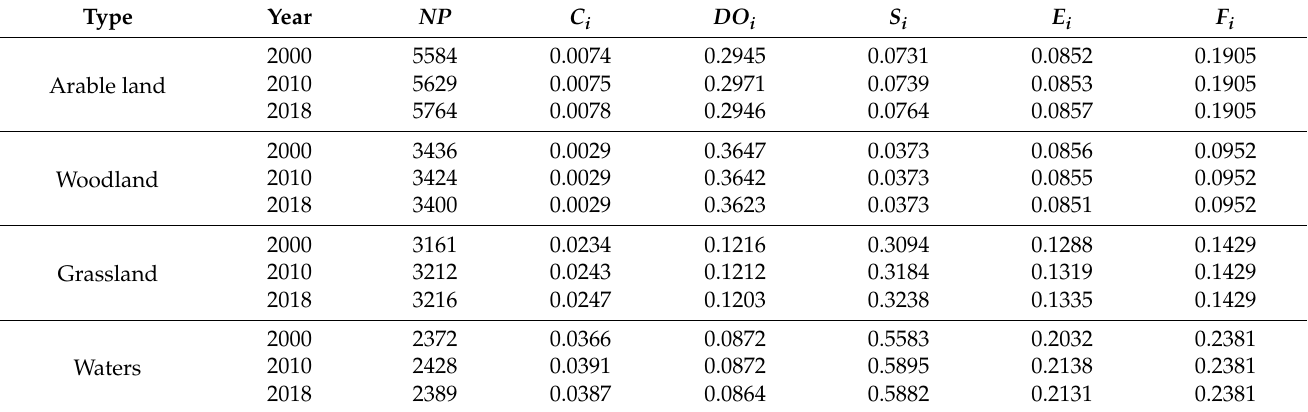
Table 6. Landscape pattern indices for different land-use